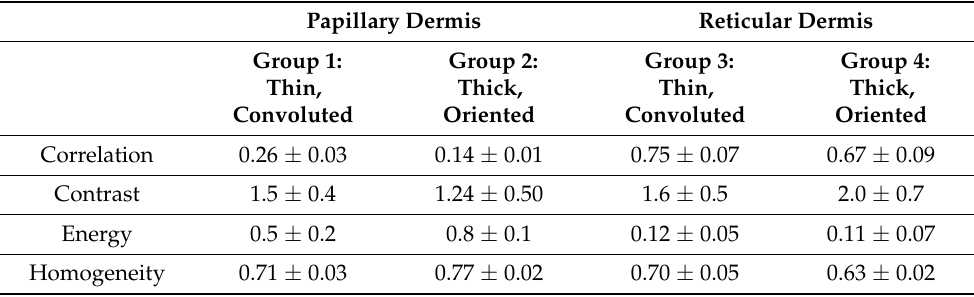
Table 2. Summary of GLCM results for native grey values. The GLCM parameters, correlation, contrast, energy, and homogeneity are shown for thin and thick datasets in the papillary and reticular dermis in native grey values. Groups 1 and 2 were extracted from a depth of 60–85 µ m on the volar forearm, and groups 3 and 4 were extracted from 85–120 µ m on the volar